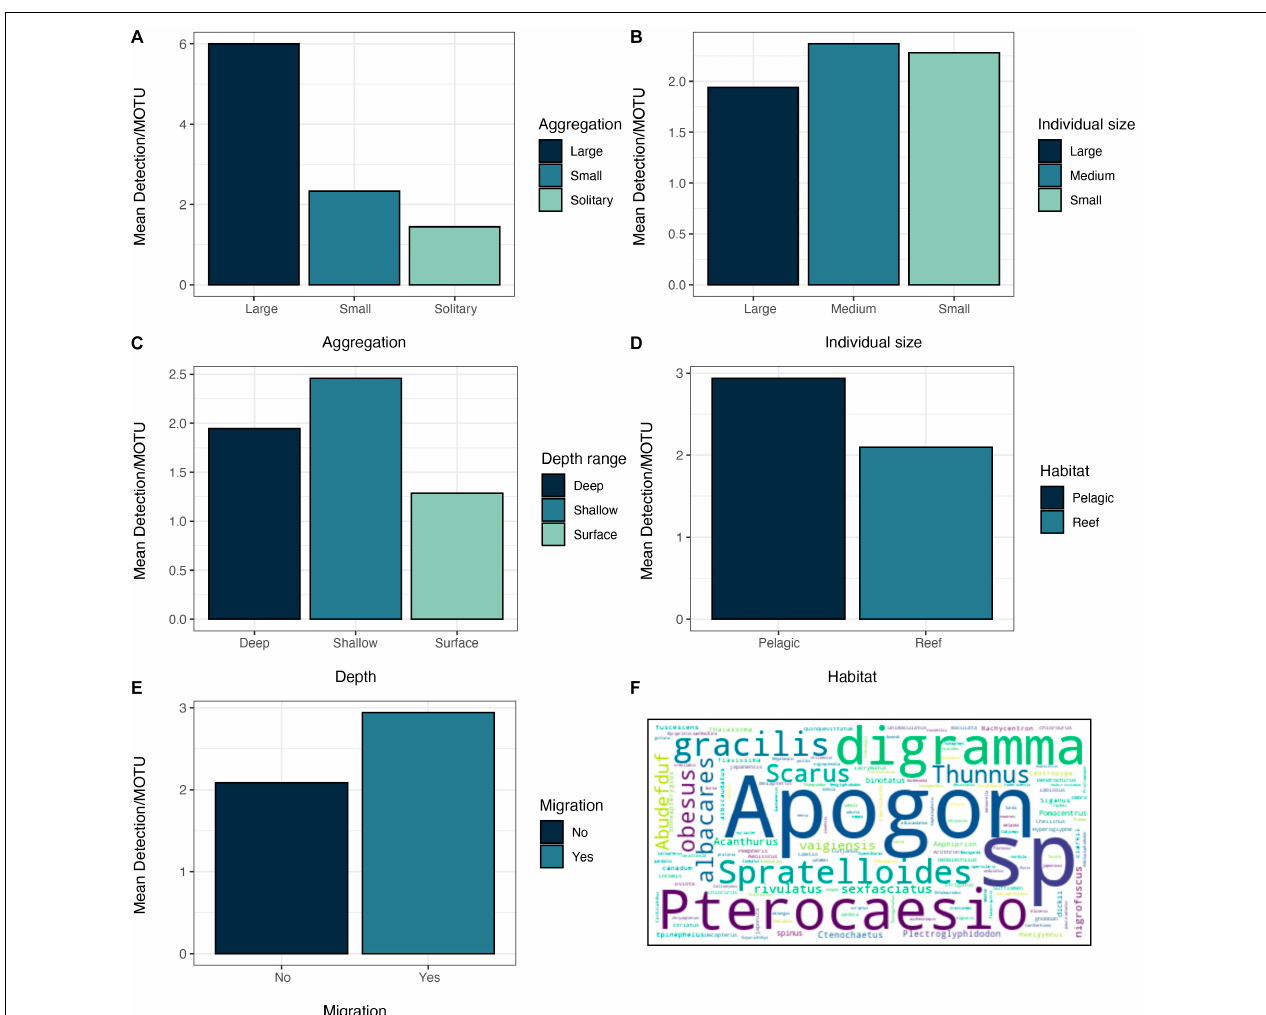
FIGURE 7 | Mean detection per MOTU of the studied fish features: (A) Aggregation behavior, (B) Individual size, (C) Depth range, (D) Habitat, and (E) Migration. (F) Names of the fish species recovered from sponge nsDNA sized according to their number of detections.